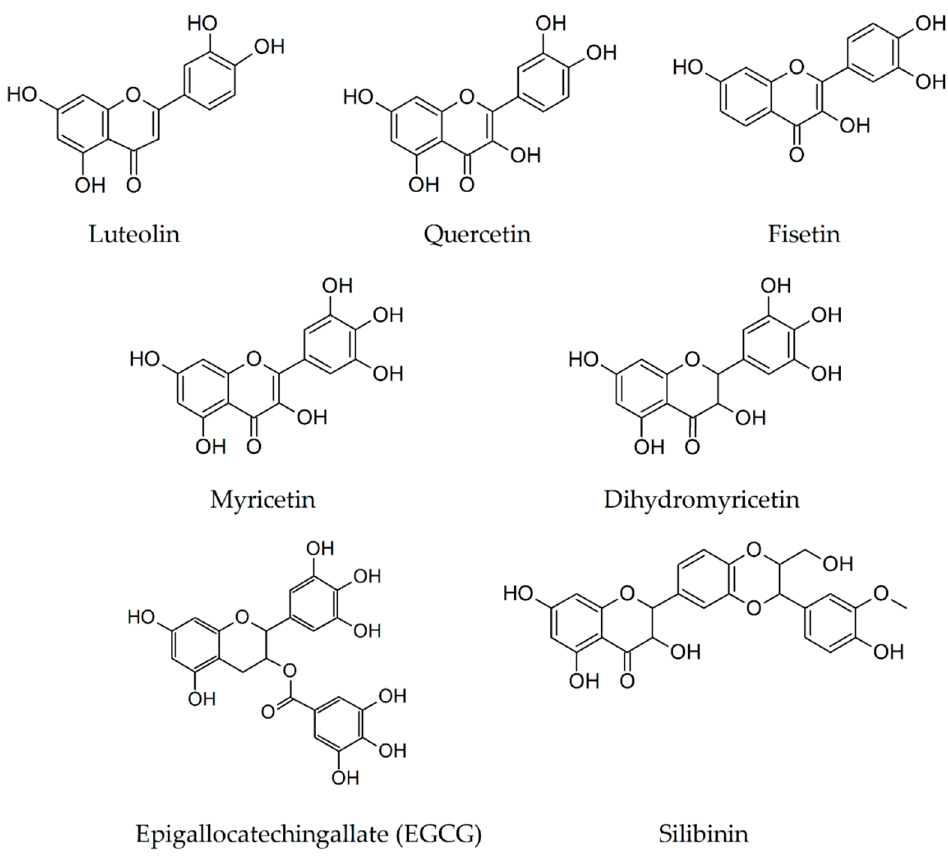
Figure 4. Chemical structures of flavonoids and flavanol-lignan silibinin from plants whose inhibitory activity towards beta-amyloid fibrillogenesis was studied.